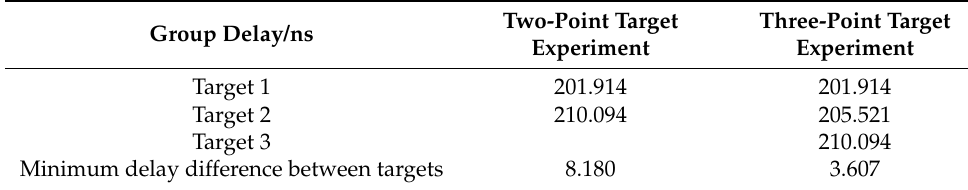
Table 4. The group delay of point